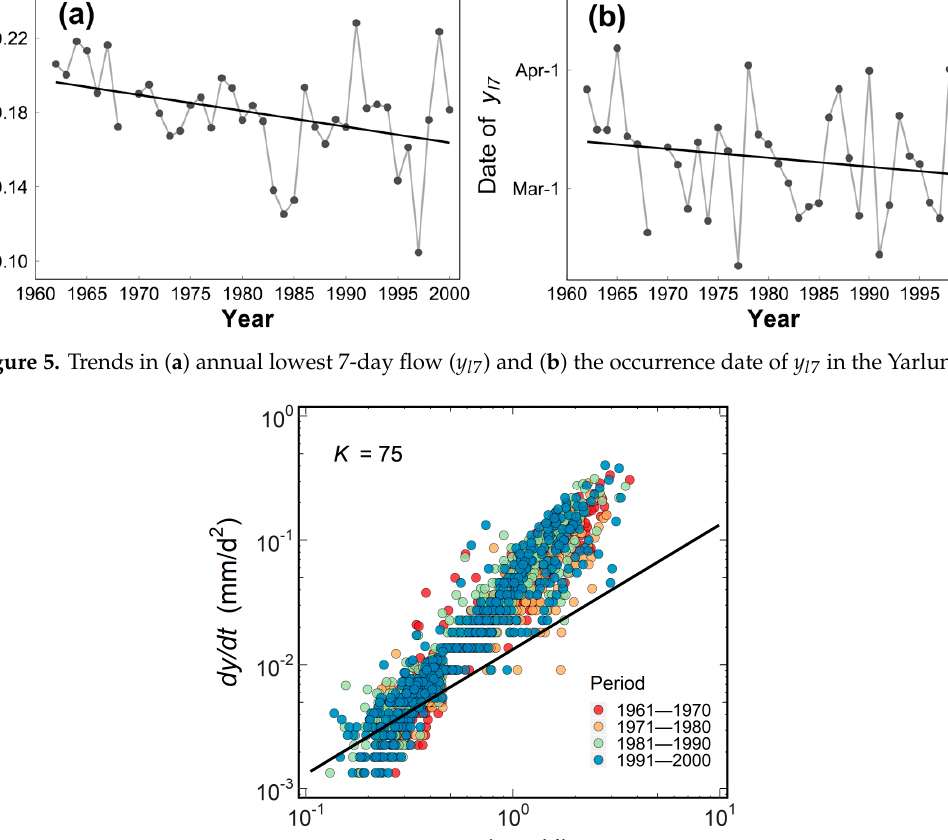
Figure 5. Trends in ( a ) annual lowest 7-day flow ( y l 7 ) and ( b ) the occurrence date of y l 7 in the Yarlung.